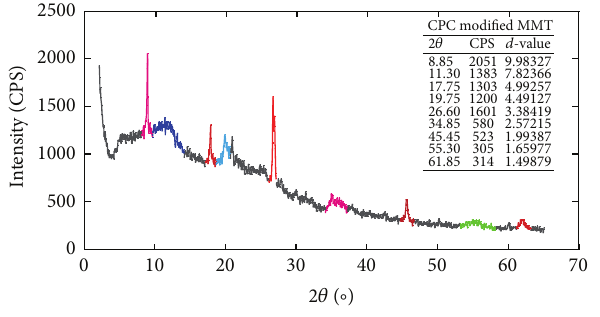
Figure 4: XRD scan of